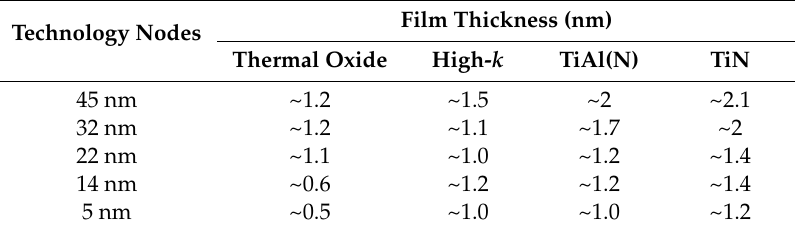
Table 1. Material selection of high- k dielectric and metal gate from 45-nm to 5-nm nodes. Film Thickness (nm) Technology Nodes Thermal Oxide High- k TiAl(N)